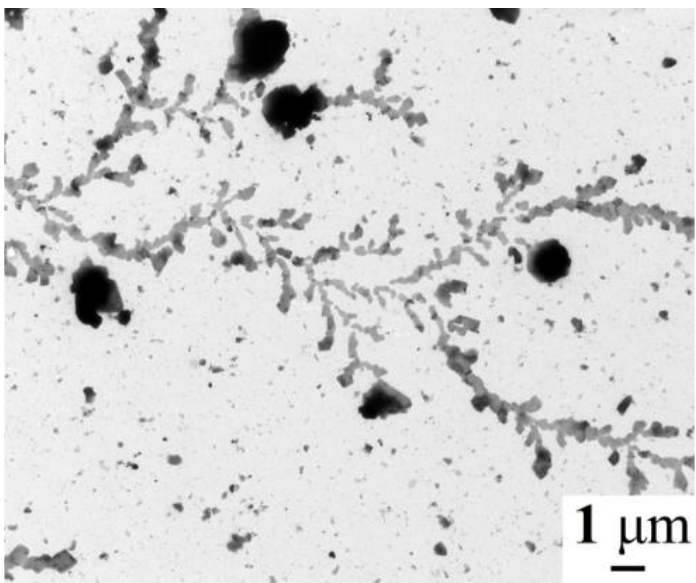
Figure 10. Recrystallization found for sample 3a .